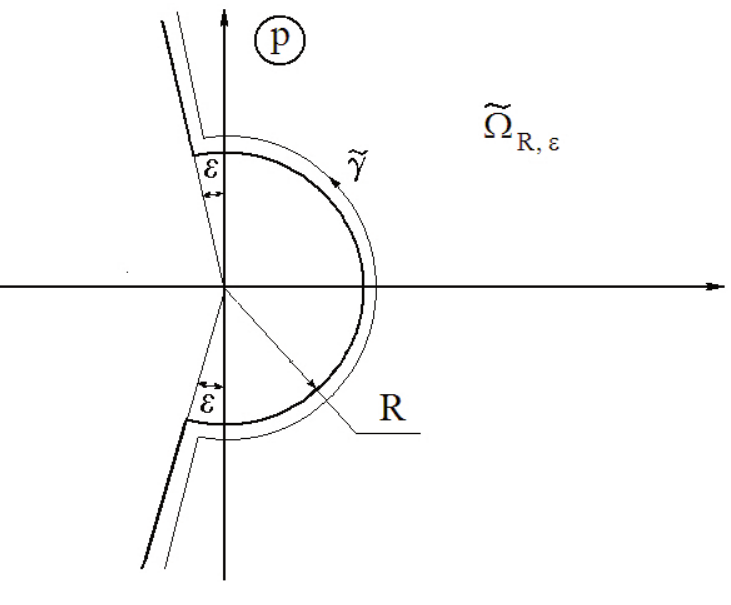
Figure 3. Contour ˜ γ and domain ˜ Ω R , ε